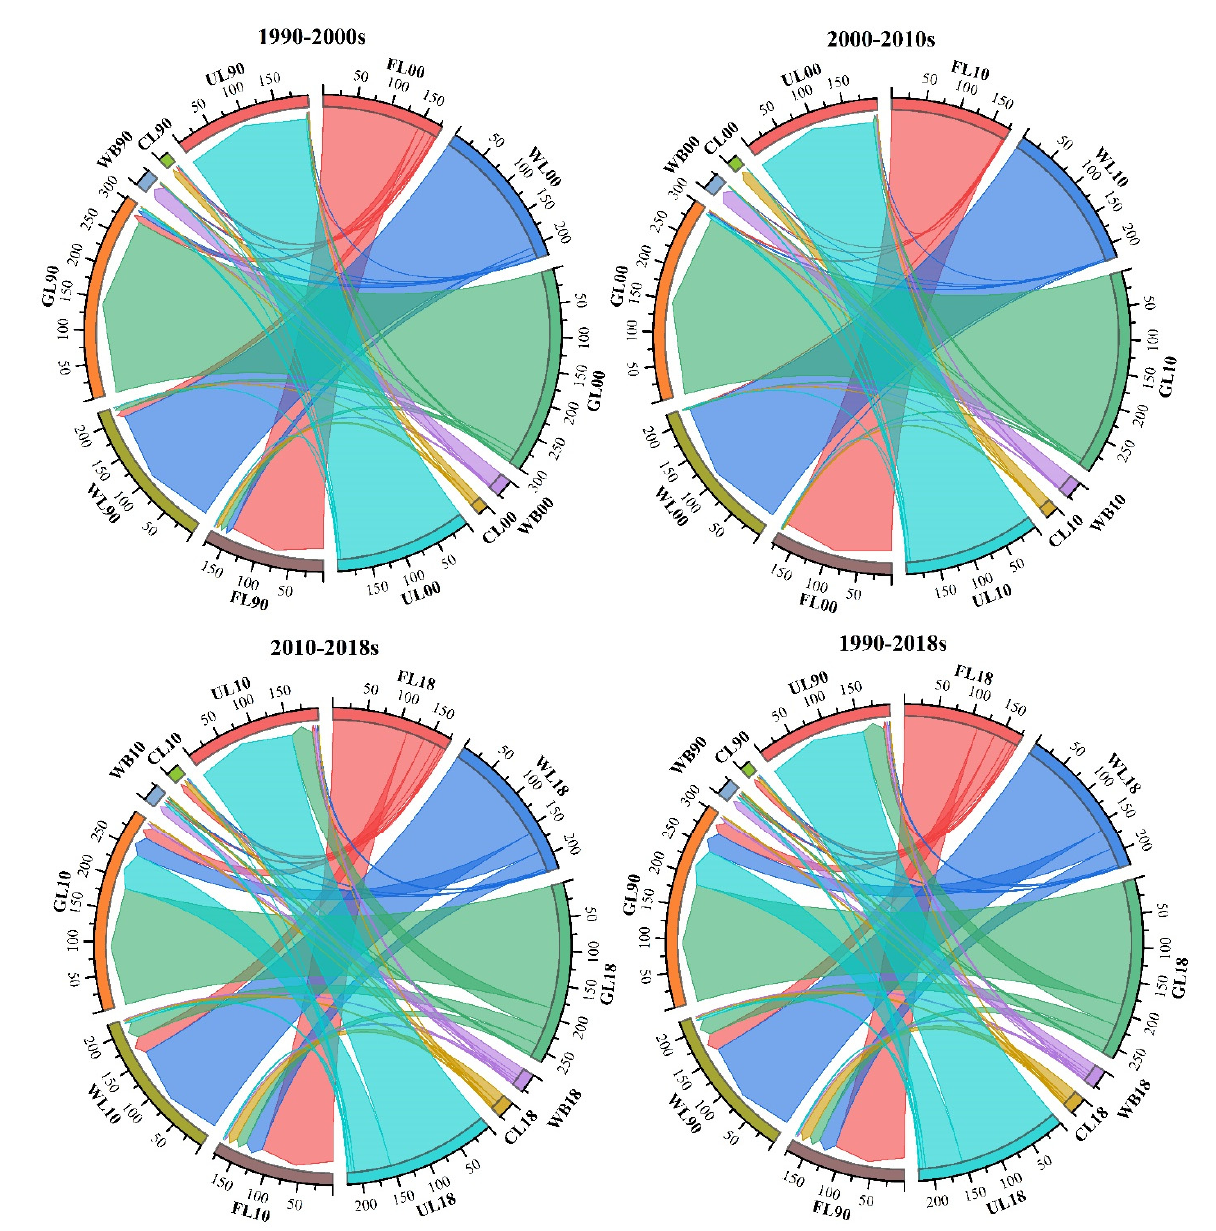
Figure 2. Chord diagram of land use type transfer in China from 1990 to 2018 (Note: FL: Farmland, WL: Woodland; GL: Grassland; WB: Water body; CL: Construction land; UL: Unused land). Table 3. Area change of different land use types in China from 1990 to 2018 (10 4 km 2 ). Water Construction Unused Farmland Woodland Grassland Body Land